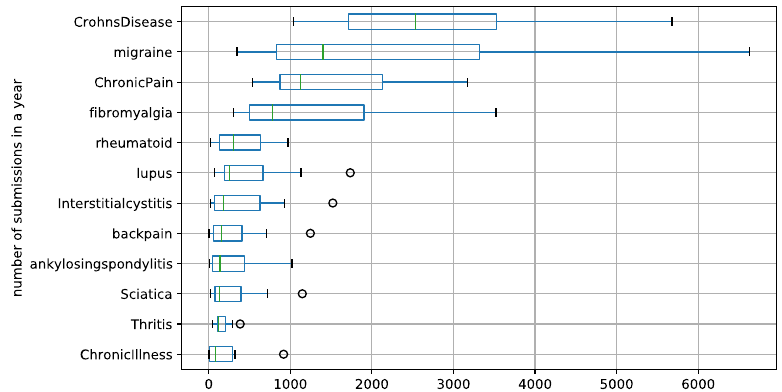
Figure A7. Distribution of the number of submissions per year for each subreddit.